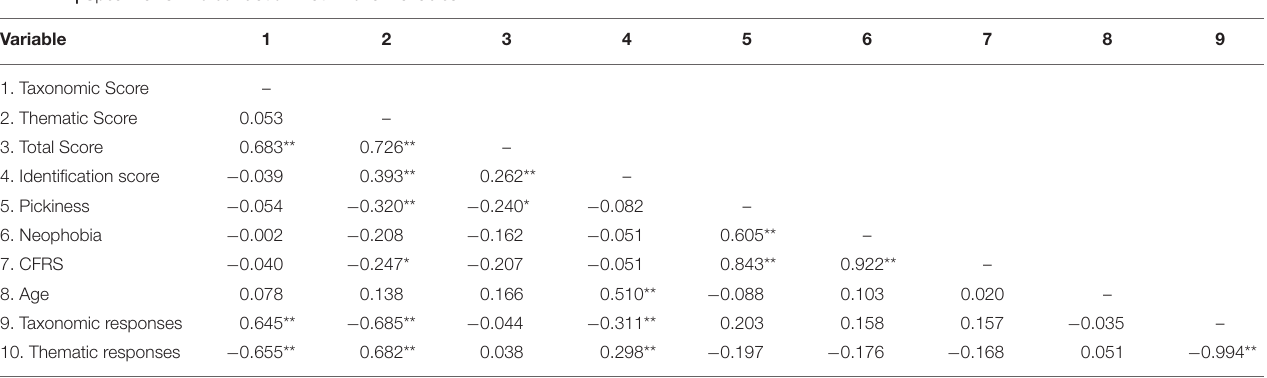
TABLE 1 | Spearman’s Rho correlation matrix for all variables.